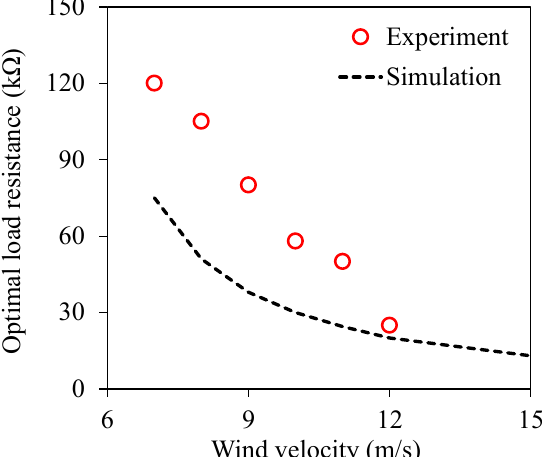
Figure 15. Variation of the optimal external load resistance with wind velocity.